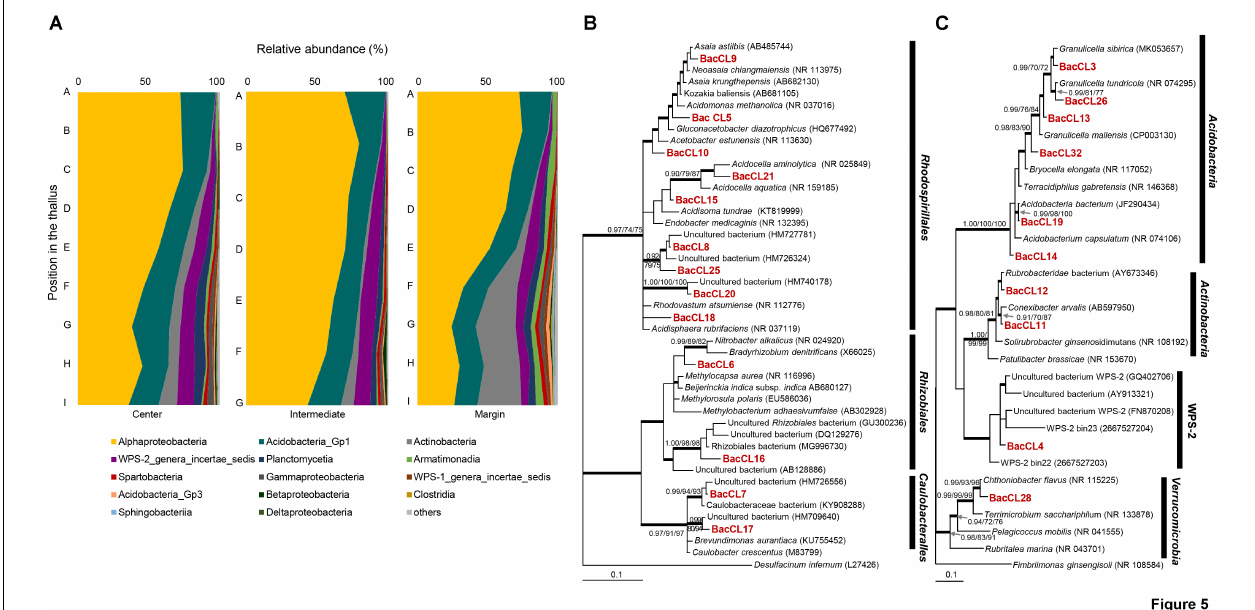
FIGURE 5 | Bacterial composition and phylogenetic trees of major bacterial OTUs. (A) Bacterial composition at the class level along the vertical positions of the thalli. (B) Bayesian tree of major OTUs of Alphaproteobacteria . The tree was rooted with Desulfacinum infernum (L27426, Deltaproteobacteria ). (C) Bayesian tree of major OTUs of other bacteria. The tree was rooted with Fimbriimonas ginsengisoli (NR_108584, Armatimonadetes ). Thick branches represent those that were conserved in Bayesian, ML, and MP analyses. Posterior probabilities and bootstrap values ( > 0.9 and > 70%) were shown on corresponding branches (Bayesian/ML/MP). Detailed information for relative abundance of each OTU was included in Supplementary Tables S5–S7